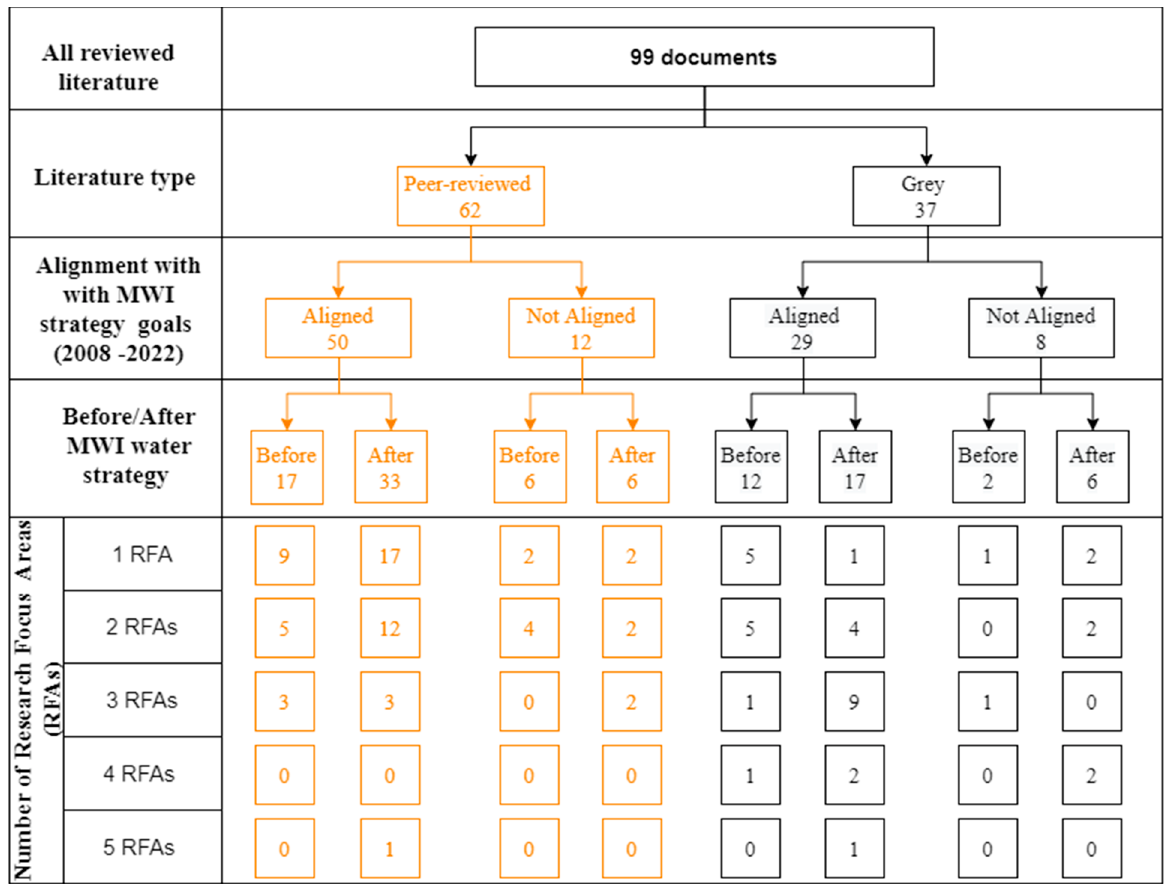
Figure 5. Summary of the results of the analysis process.